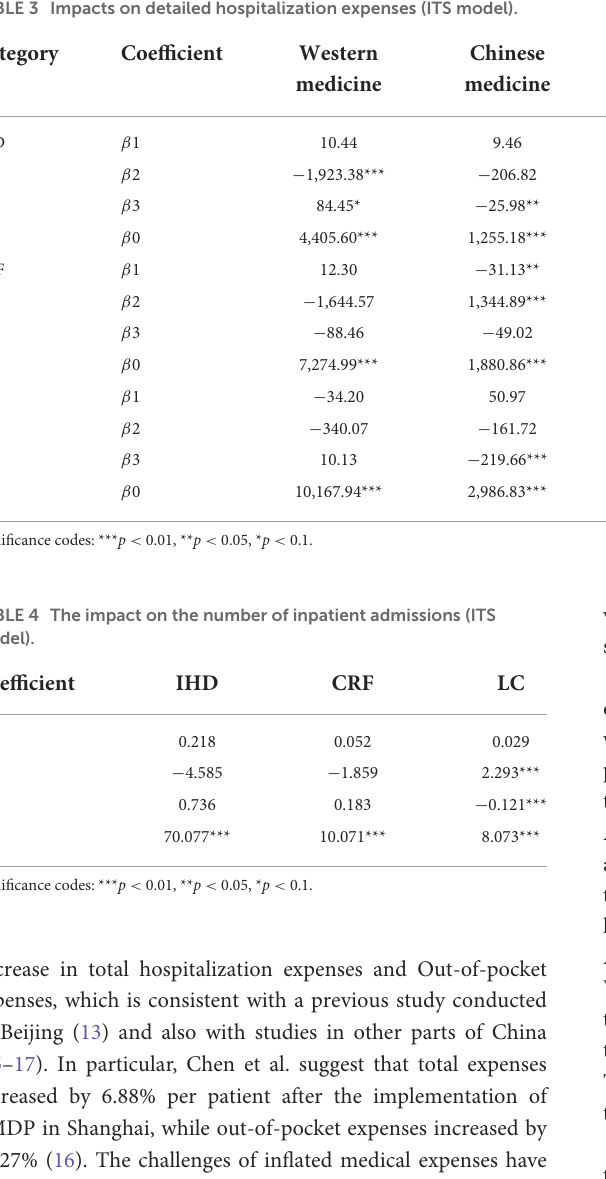
TABLE 3 Impacts on detailed hospitalization expenses (ITS model).